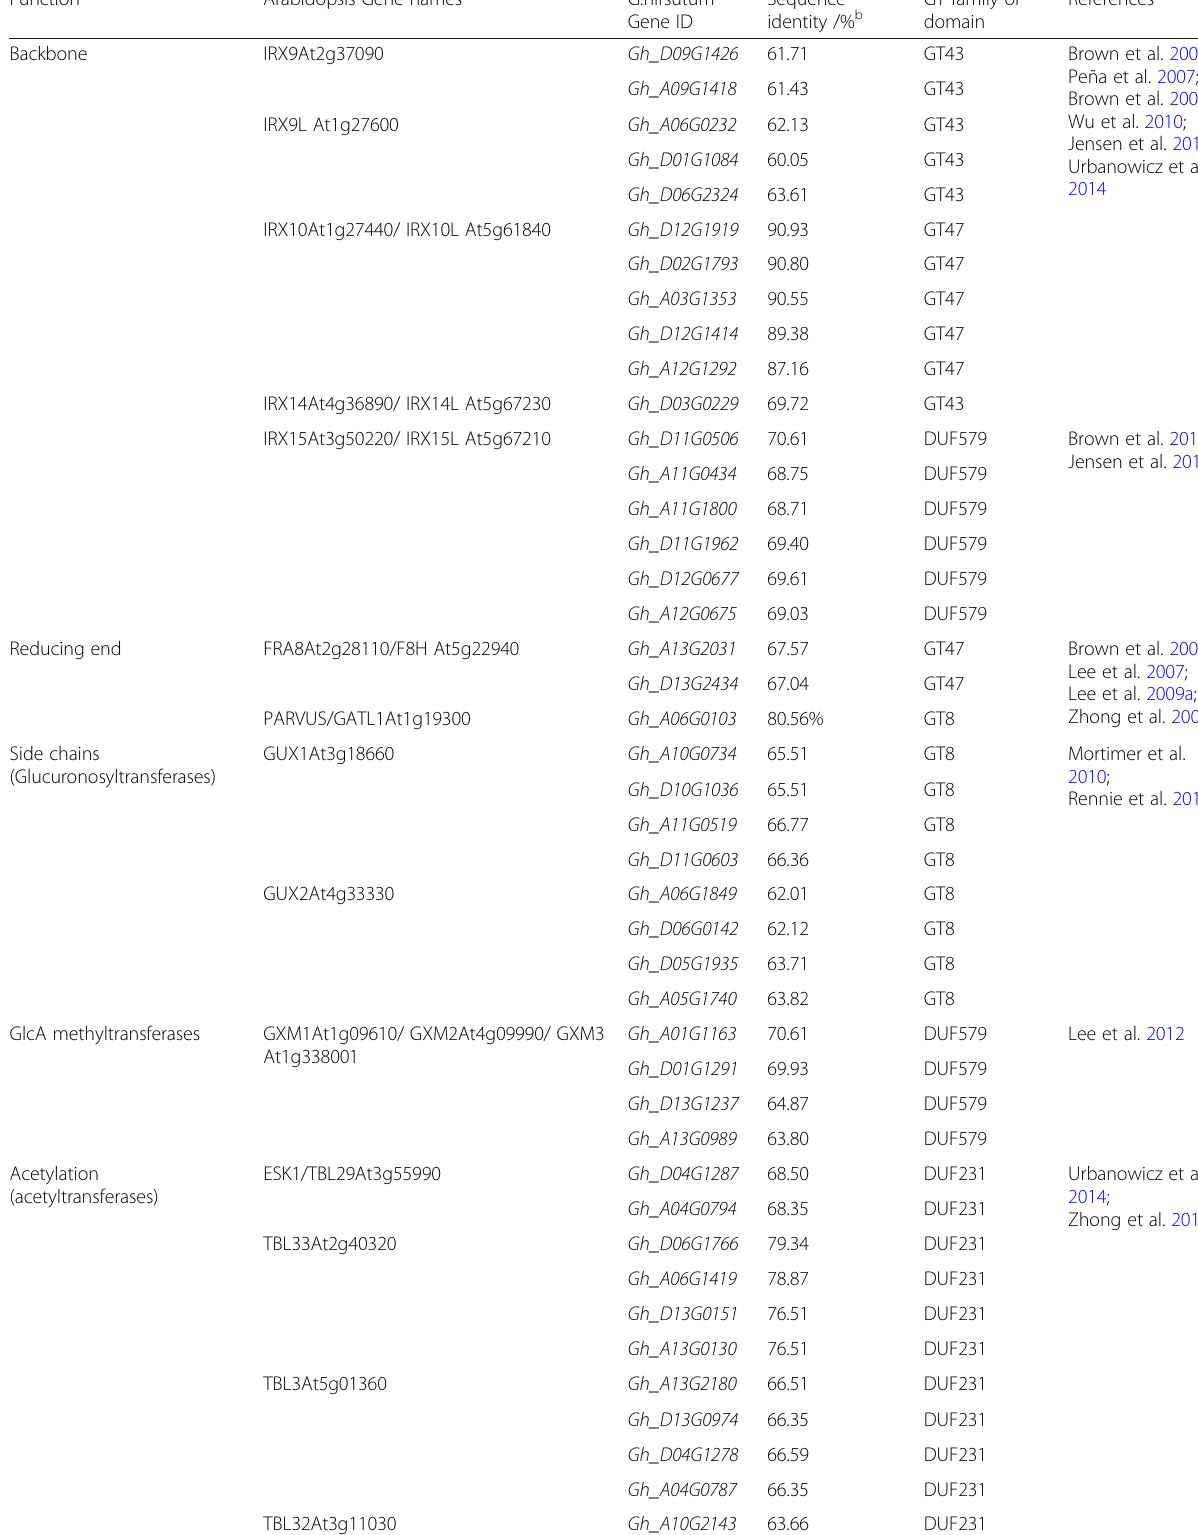
Table 1 Fifty-five candidates involved in fiber xylan synthesis in upland